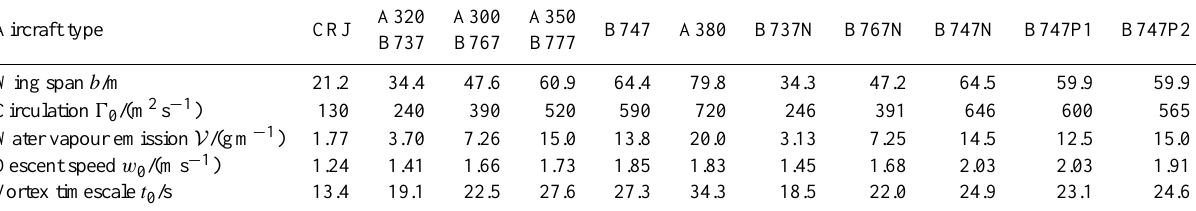
Table 1. List of aircraft-dependent parameters. Columns 2–7: values used in UG2014; columns 8–10: values used in Naiman et al. (2011); column 11: values used in Paugam et al. (2010); column 12: values used in Picot et al. (2015). Aircraft type